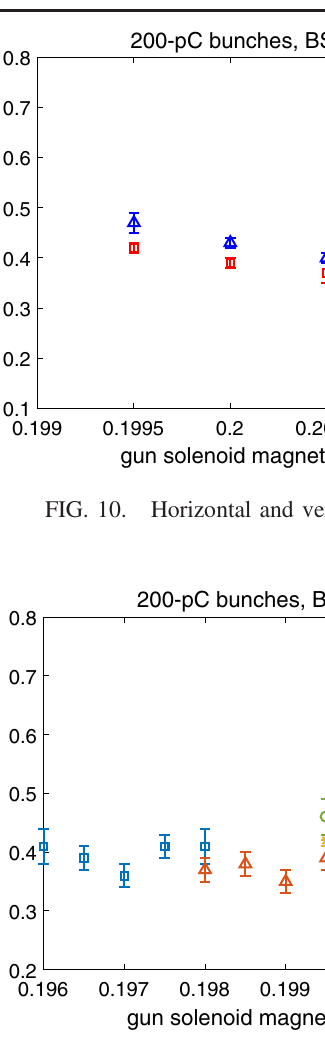
FIG. 11. The change in emittance of 200-pC and 500-pC bunches with different launch phases and 1.8 mm diameter BSA as a function of gun solenoid magnet gradient.